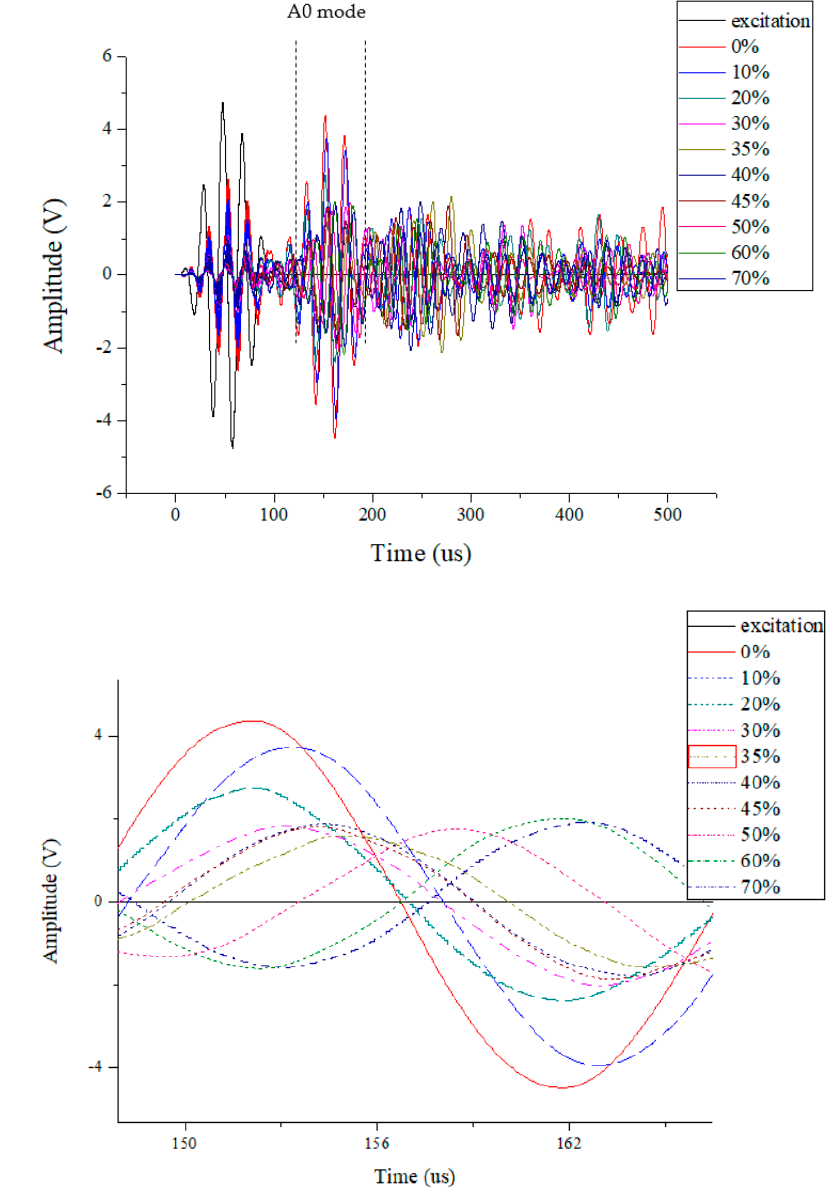
Figure 12. Signal data from the PZT elements at the condition that the central sensor is not debonded and the debonding area of peripheral actuators increases sequentially: ( a ) Lamb wave signal monitored by the system; ( b ) the time window of the A0 mode Lamb wave.